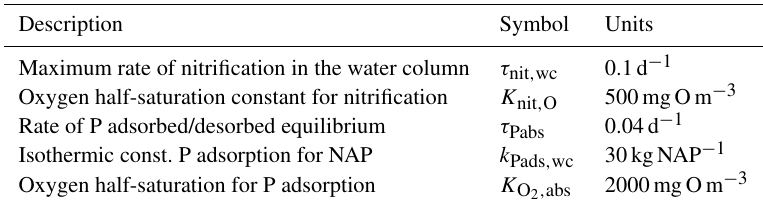
Table 10. Constants and parameter values used in the water column inorganic chemistry.